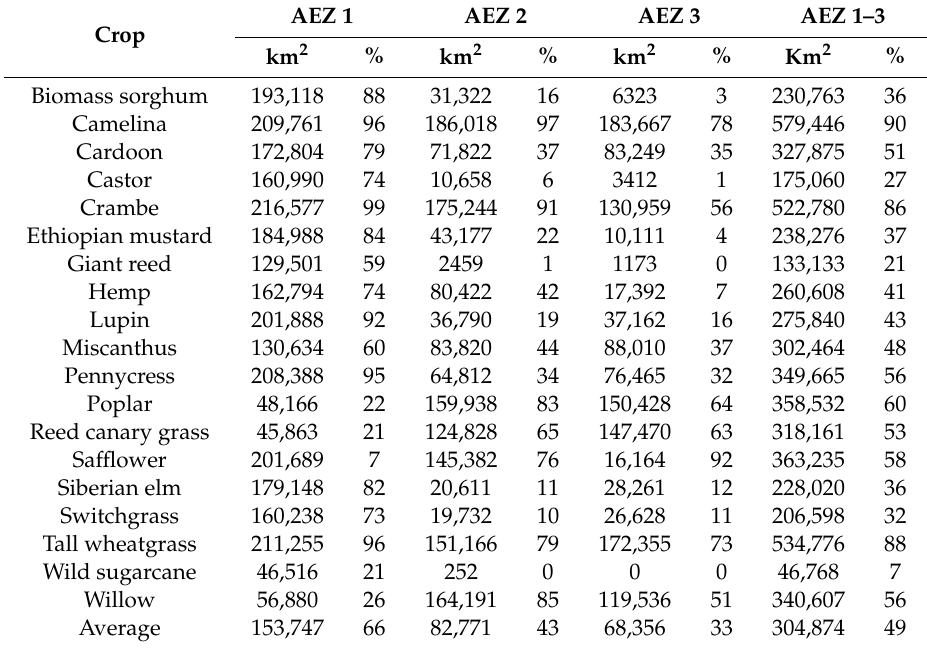
Table A3. Total area (km 2 ) per selected industrial crop suitable for cultivation on marginal land across Europe (EU-28) and share (%) of marginal land suitable for cultivation of the